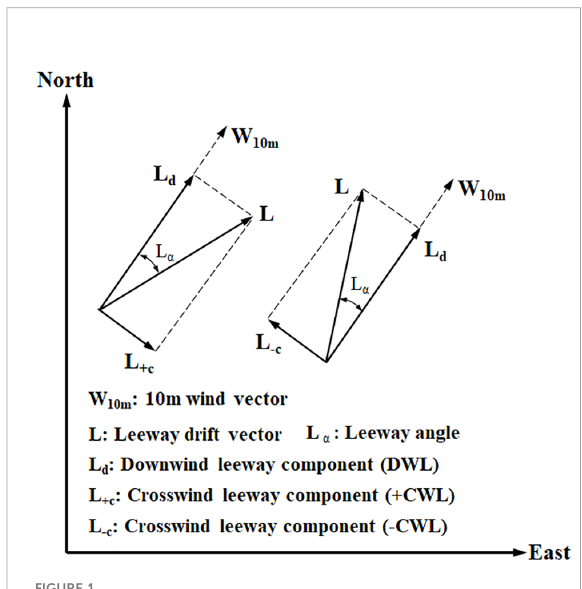
FIGURE 1 The relationship between the leeway drift vector, the downwind leeway component and the crosswind leeway